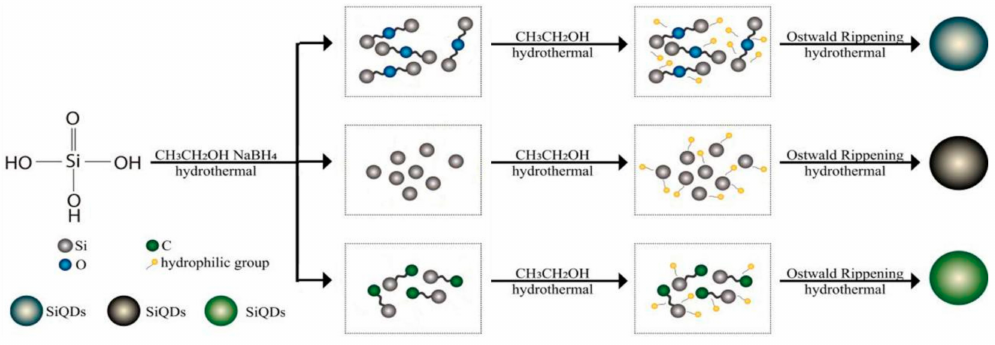
Figure 6. Mechanism of SiQDs.